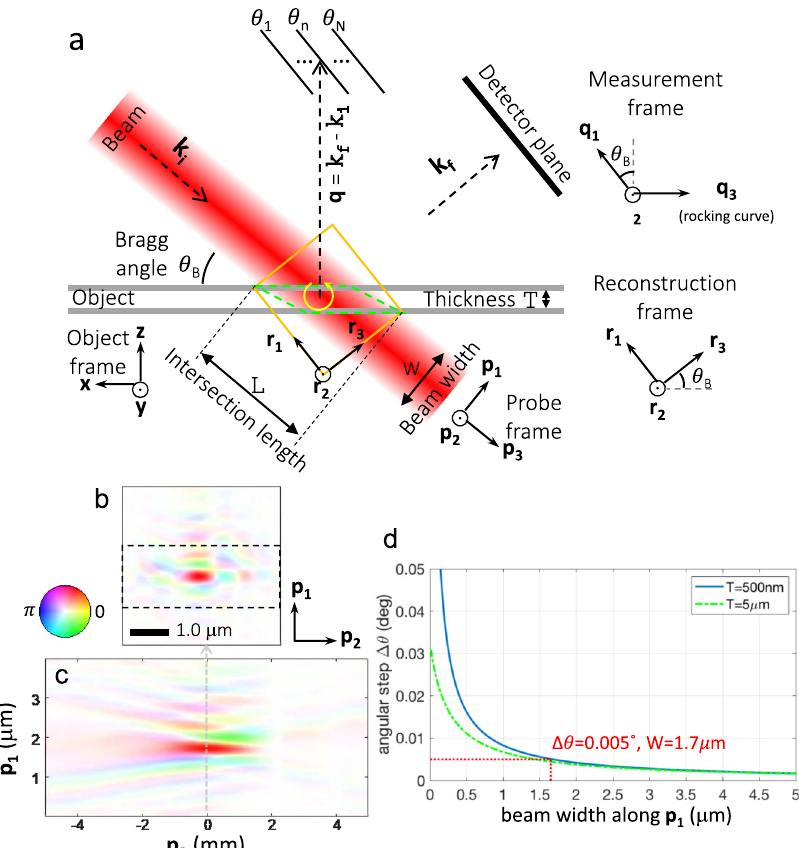
Fig. 2 Bragg ptychography and sampling principles. a In the ( x , y , z ) laboratory frame, a fi nite size beam illuminates a crystalline thin fi lm sample in Bragg geometry, while a 2D detector collects the coherent diffracted pattern, so that the incident and exit wave vectors ( k i and k f , respectively) ful fi l the Bragg condition. The 3D information is acquired by rotating the sample in the vicinity of the Bragg angle θ B , along the rocking curve, i.e. at the θ 1 … θ N positions. The intensity information is recorded as a function of ( q 1 , q 2 , and q 3 ), the components of the wave-vector transfer q . Using a recently developed formalism 40 , this sampling depicts a direct space frame ( r 1 , r 2 , r 3 ). It implies sampling rates along the three directions, that ensure that the illuminated volume (delimited by the green line) is contained within the numerically retrieved direct space (shown as an orange rectangle). The probe frame is also de fi ned as ( p 1 , p 2 , p 3 ). b A typical hard x-ray probe pro fi le presented at the focal plane and ( c ) numerically propagated along the beam axis (see Methods). The dashed rectangle corresponds to the accessible region based on the parameters used during the acquisition of the BP dataset. The full extent of the probe, visible outside this rectangle, is only retrieved through the implementation of the angular up-sampling approach. Along the propagation direction, note the probe invariance over distances as large as a few hundreds of micrometres. The hue rendering colour scale is indicated in ( b ). d Suf fi ciently small sampling steps of Δ θ are needed to ful fi l the numerical sampling relation. This relation is depicted in the plot, as a function of the probe size W and the sample thickness